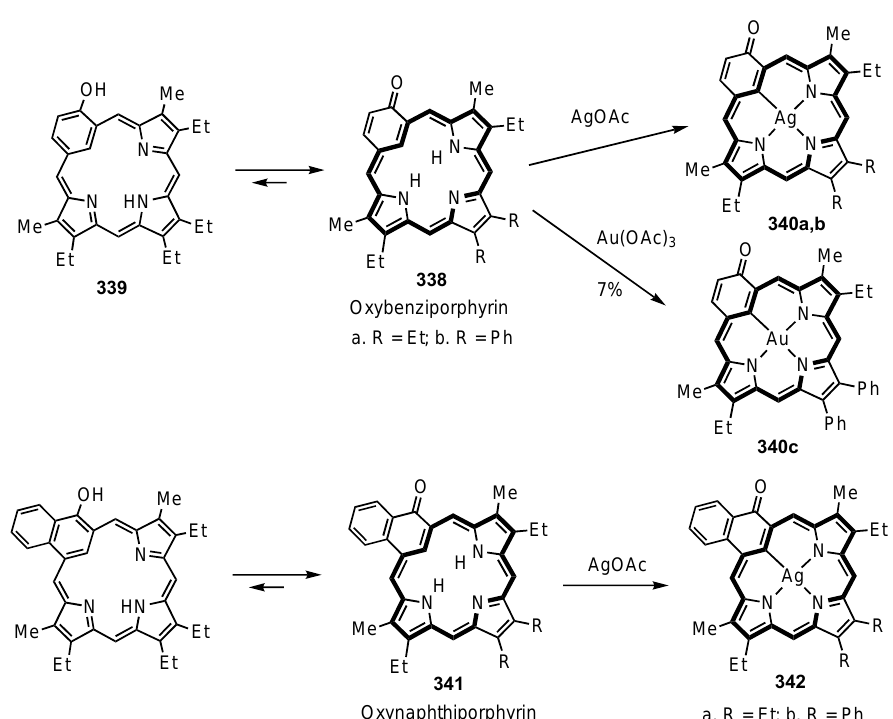
Scheme 55. Silver(III) complexes of oxybenzi- and oxynaphthiporphyrins.